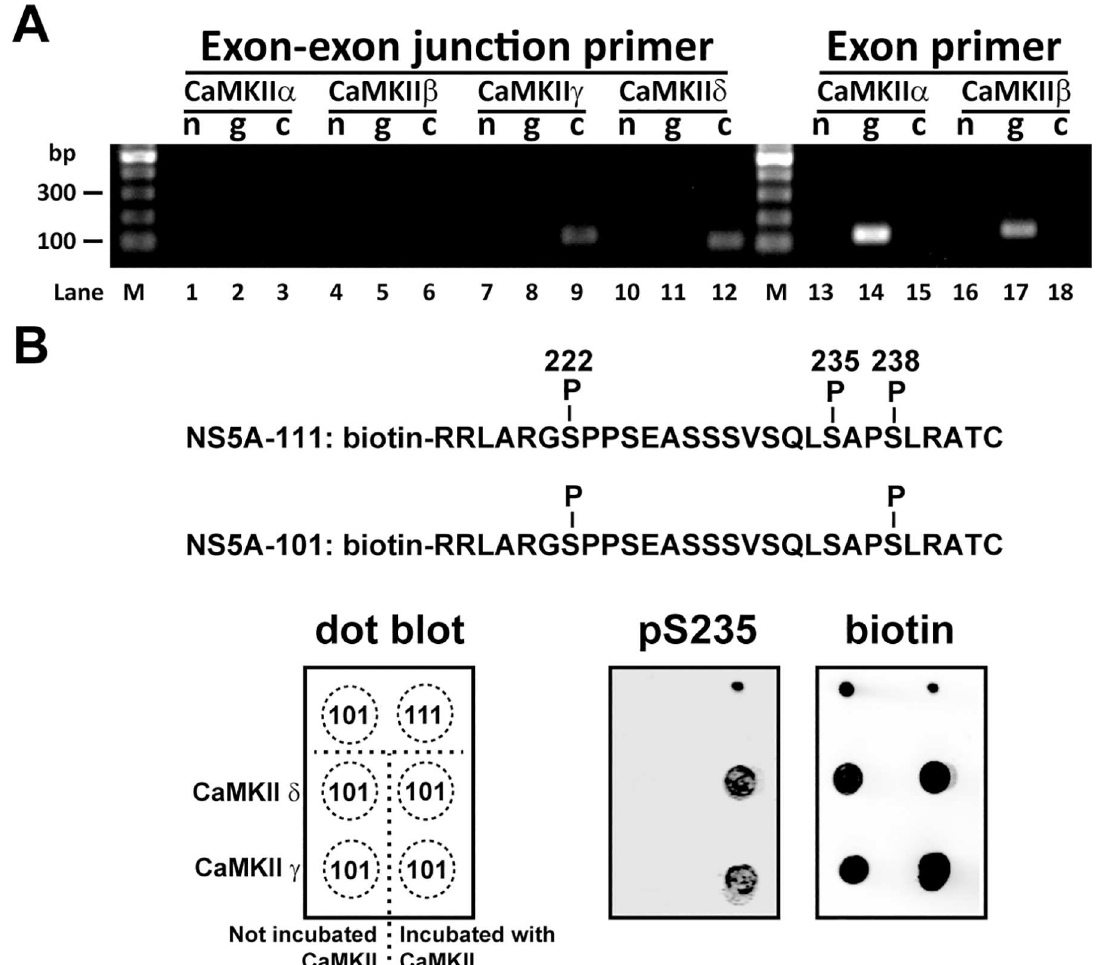
Fig 4. CaMKII γ and δ expressedin the Huh7.5.1 cells can directly phosphorylate NS5A S235. (A) Expression of CaMKII isoforms in the Huh7.5.1cells by RT-PCR analysis. Expression of CaMKII ( γ and δ ) mRNA was assessedwith the genomic(g) and cDNA (c) libraries of the Huh7.5.1cells using primers that span two neighboring exons (exon-exonjunctionprimer) to avoid false positive signal from the genomicDNA. No template (n) served as negativecontrols. Lack of CaMKII ( α and β ) mRNA expressionwas doublechecked with primer pairs within the same exons (exon primer). The lanes are numbered. Lane M indicatesDNA markers in base pairs (bp). (B) In vitro kinase assay. Three digits were used to denotethe phosphorylation status of the three serineresidues 222, 235 and 238 in the biotin-labeled synthetic NS5A peptide(NS5A-111and NS5A-101). Numbers 1 and 0 represent phosphorylation and non-phosphorylation,